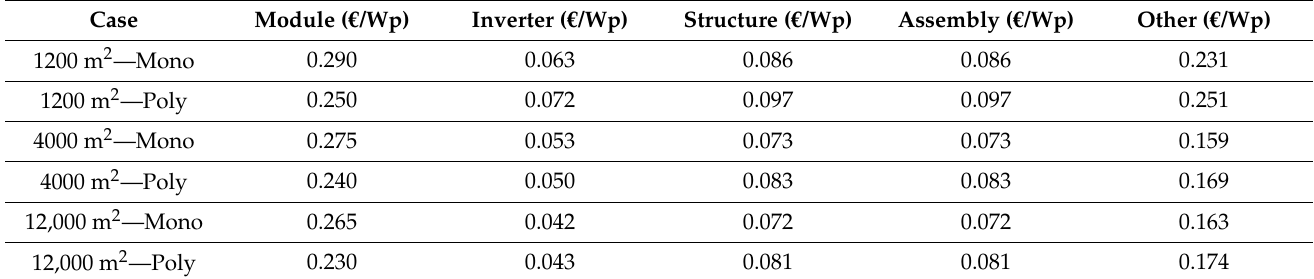
Table 5. Normalized costs for installations with 20 ◦ inclination.